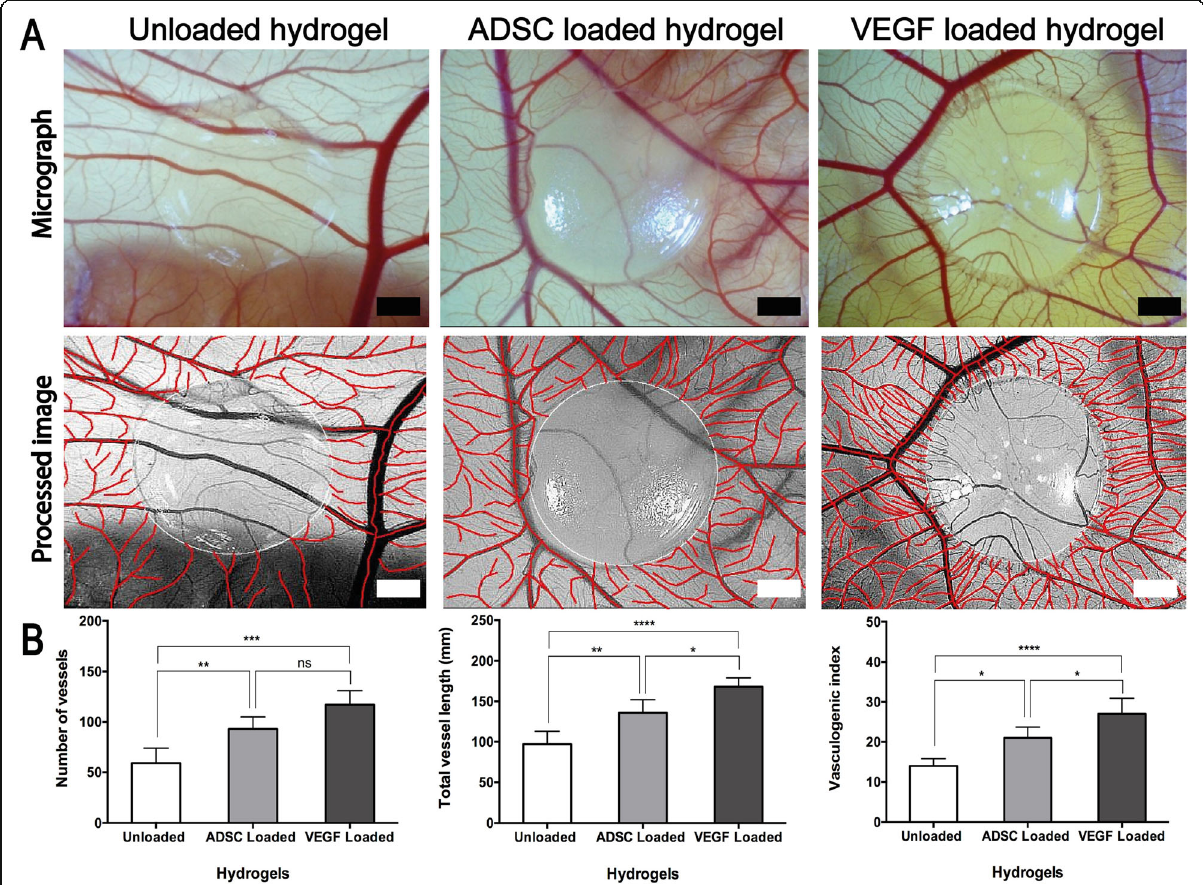
Fig. 12 Comparison of angiogenic ability among Unloaded hydrogel group, ADSC loaded hydrogel group and VEGF loaded hydrogel group. a Micrographs (upper row) and semi-automatic processed images (lower row) of the hydrogel, hydrogel containing ADSCs and hydrogel containing VEGF (positive control), taken on day 14 of embryonic development (Scale bars 2 mm). b The change in total number of vessels, total vessel length and vascularization index of ADSC and VEGF loaded hydrogels calculated from processed images. Reproduced with permission [124]. Copyright (2017), Elsevier